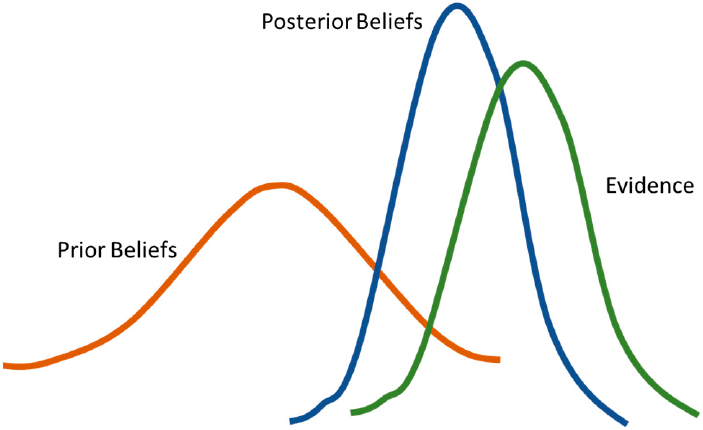
Figure 4. The concept of the Bayesian model, modified from [34].